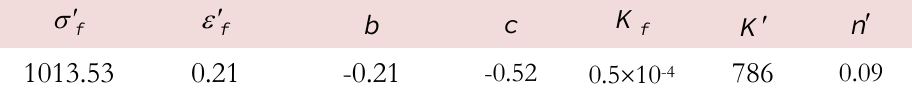
Table 2: Cyclic strain life properties of 2024 T351 Aluminium